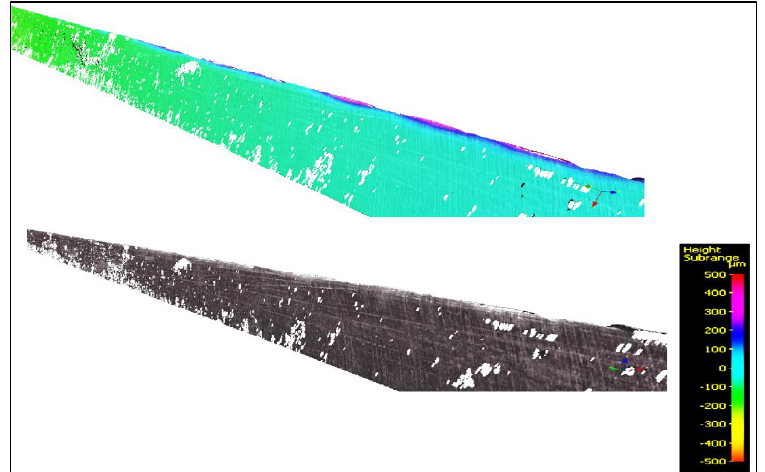
Figure 12. Cutting edge wear—knife No. 3—Norway Figure 11. The course of the experimental measurement of delimbing — delimbing knife No.3. Figure 12. Cutting edge wear — knife No. 3 — Norway spruce.